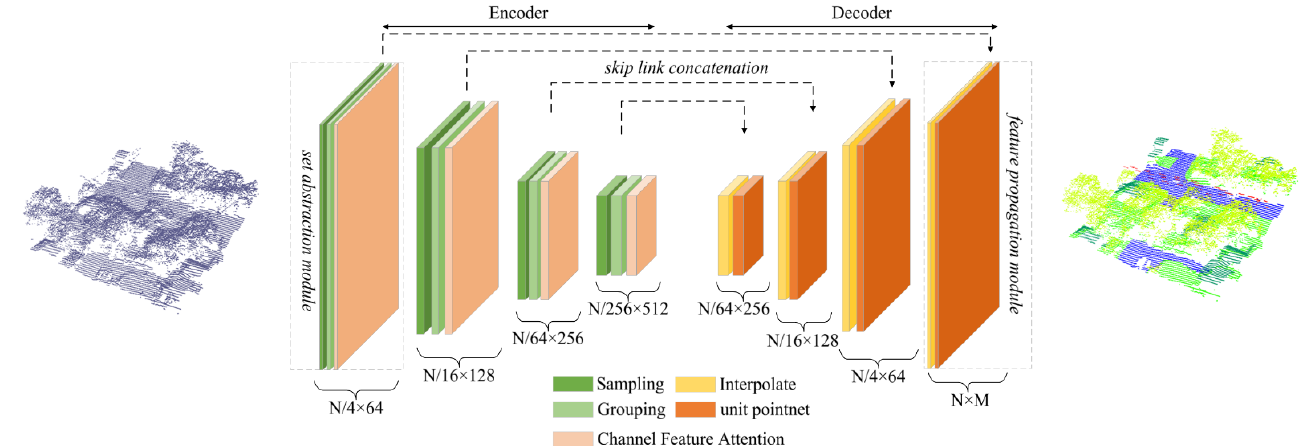
Figure 3. An illustration of the proposed SE-PointNet++.